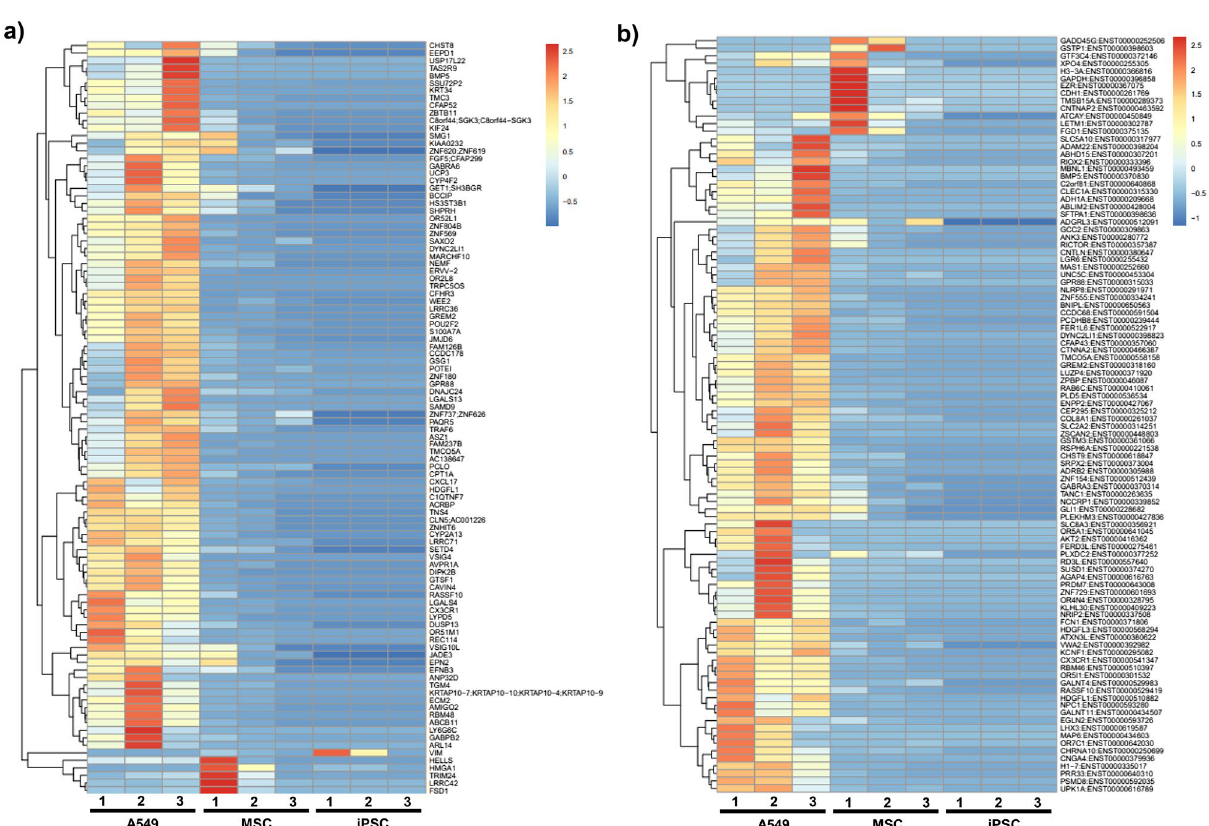
Figure 6. Heatmaps of EV-associated transcripts. RNA sequencing of EV-associated lncRNAs was performed on three biological replicates of A549, MSC, and iPSC EVs. Corresponding heatmaps show the differential expression of (a) unspliced transcripts, (b) spliced transcripts, (c) known lncRNAs, and (d) novel transcripts among EVs for each